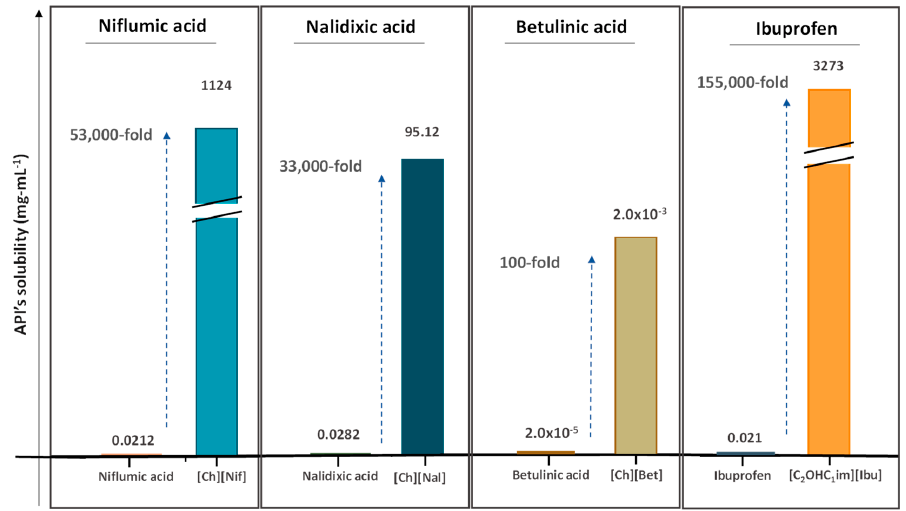
Figure 12. Example of solubility enhancements provided by API-ILs in aqueous media in comparison with the parent APIs and their dissolution in water (mg mL − 1 ) (adequate references are given along the current